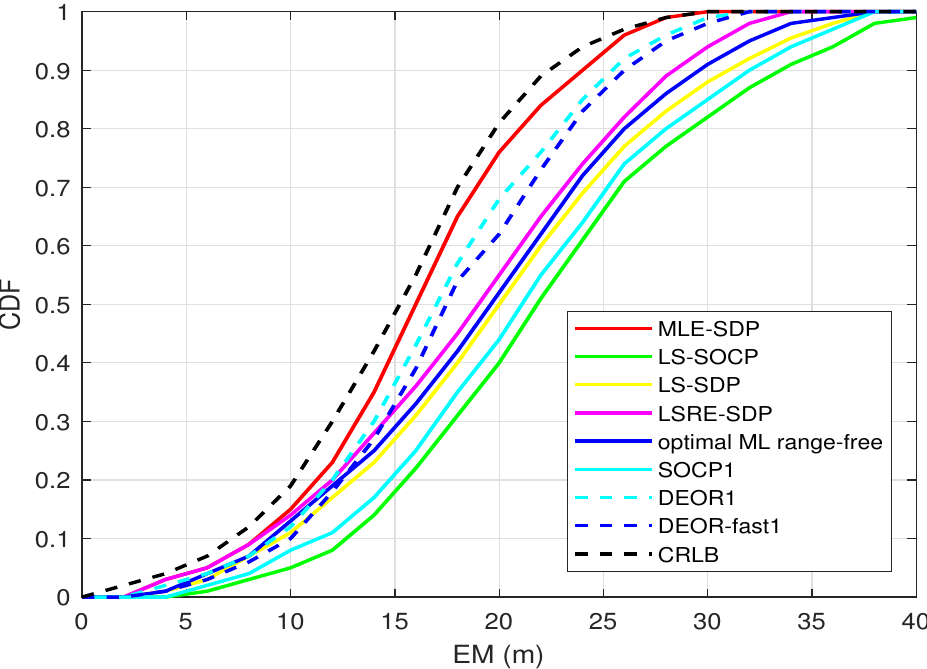
Figure 4. When L 0 is known, this is the CDF.